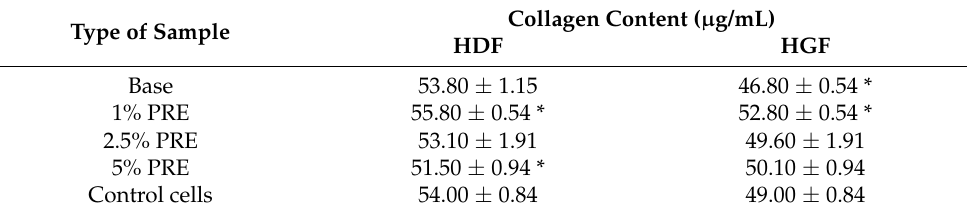
Table 10. Collagen content in the culture medium determined by the Sircol Collagen Assay after 24 h of incubation of HDF and HGF fibroblasts with the test sample at a concentration of 10 µ g/mL. Type of